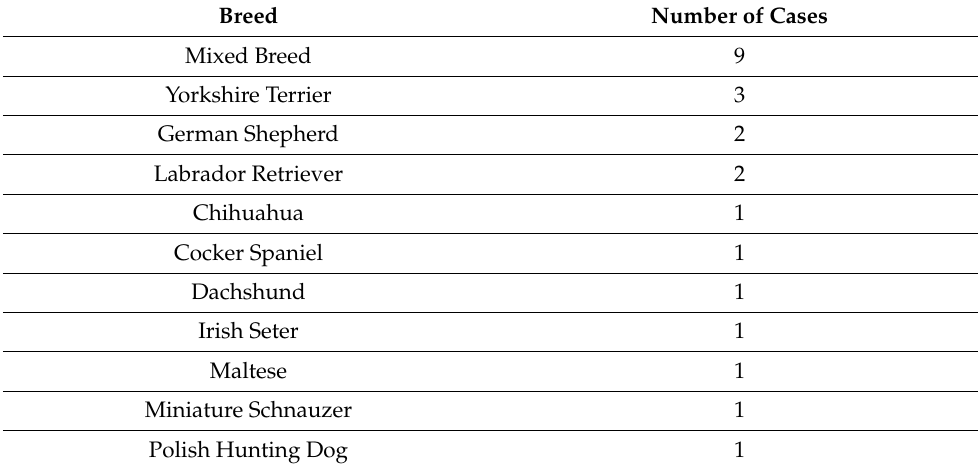
Table 1. The breeds of the cadavers used in the study. Breed Number of Cases Mixed Breed